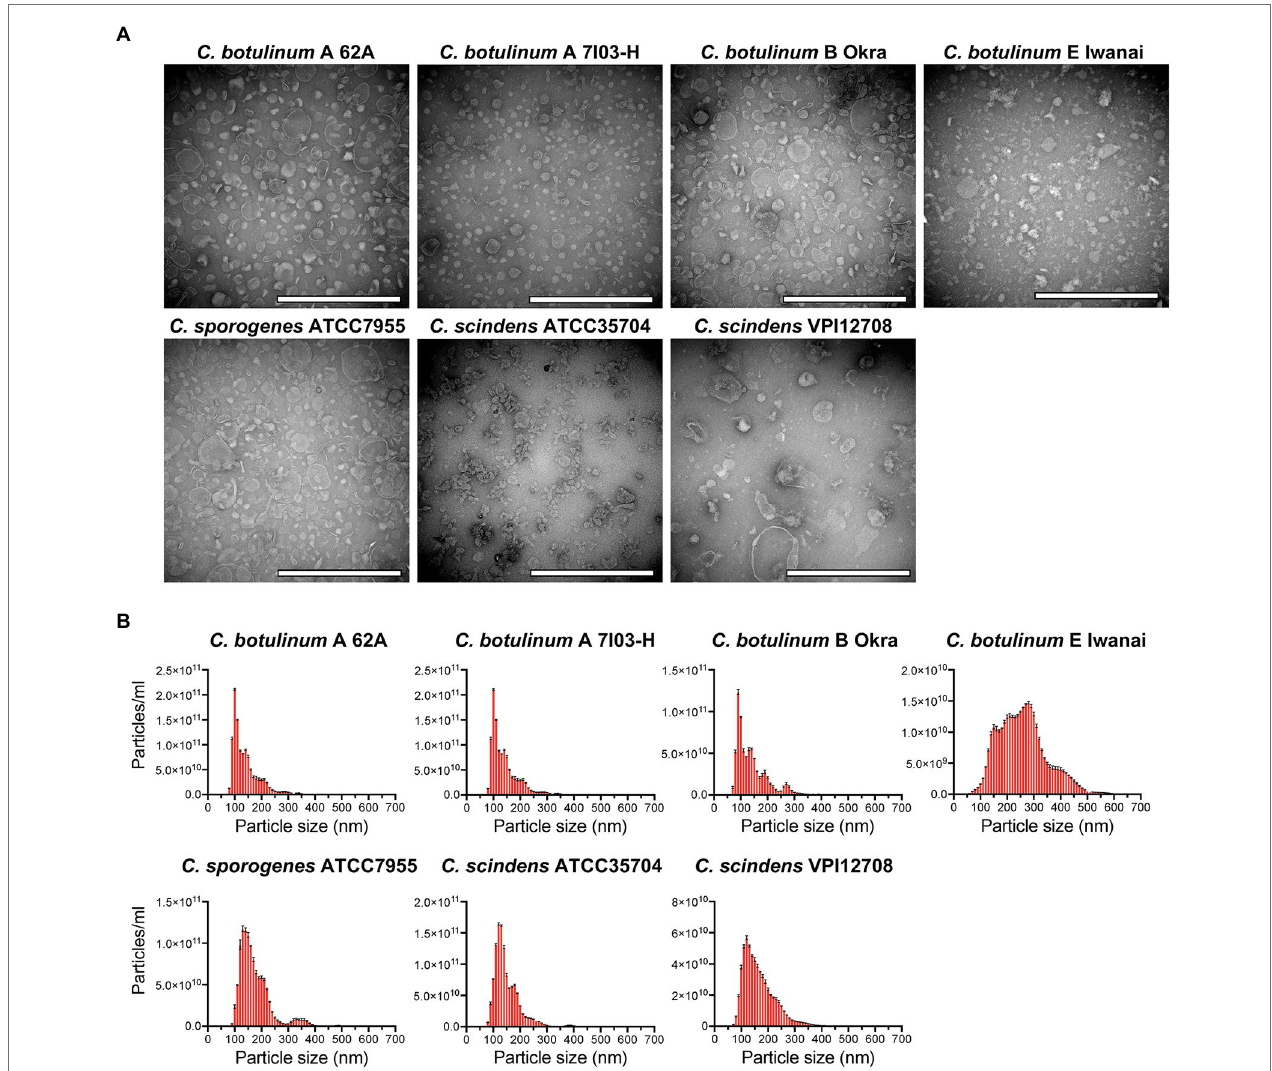
FIGURE 1 | Isolation of membrane vesicles (MVs) from Clostridium botulinum , Clostridium sporogenes , and Clostridium scindens . (A) Transmission electron microscopy (TEM) analysis of purified MVs. Bars, 200 nm. (B) Size distributions of MVs analyzed by nanoparticle tracking assay (NTA). Error bars indicate the SD of three measurements. Data are representative of at least two lots of MVs purified on different